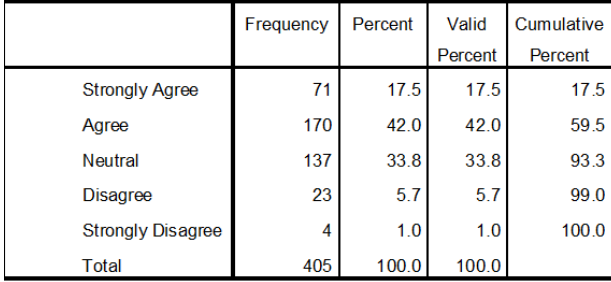
Figure 15. The change in the role and competencies of CIO has resulted in an increase in the company